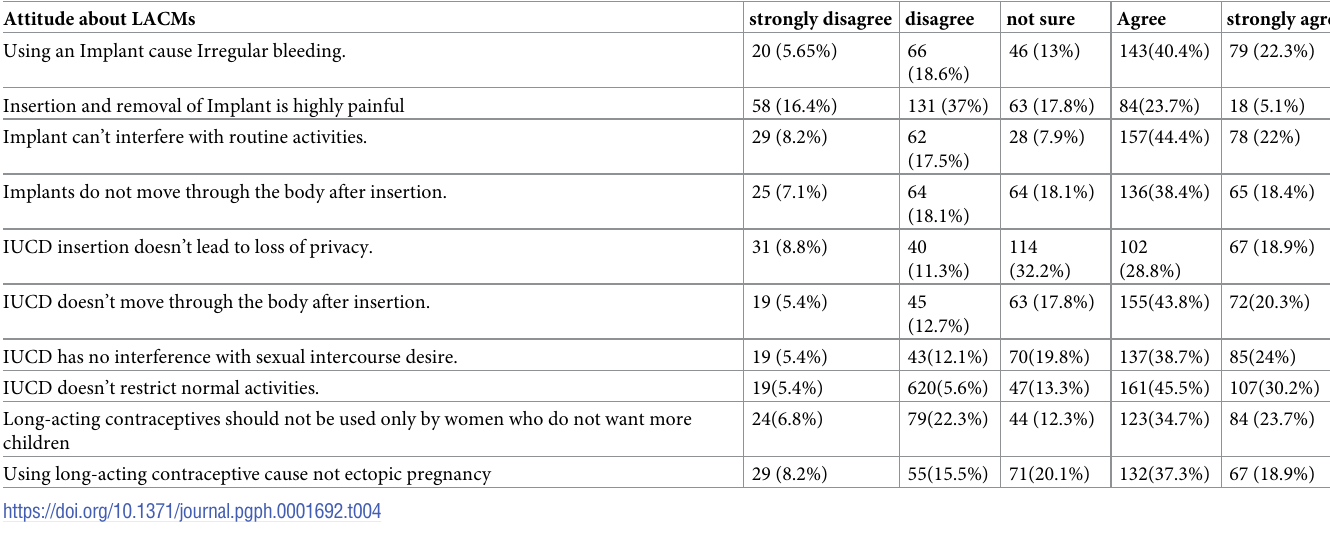
Table 4. Attitude towards long-acting contraceptive among female healthcare providers in South Wollo Zone governmental hospitals, 2021. n = 354. Attitude about LACMs strongly disagree disagree not sure Agree strongly agree Using an Implant cause Irregular